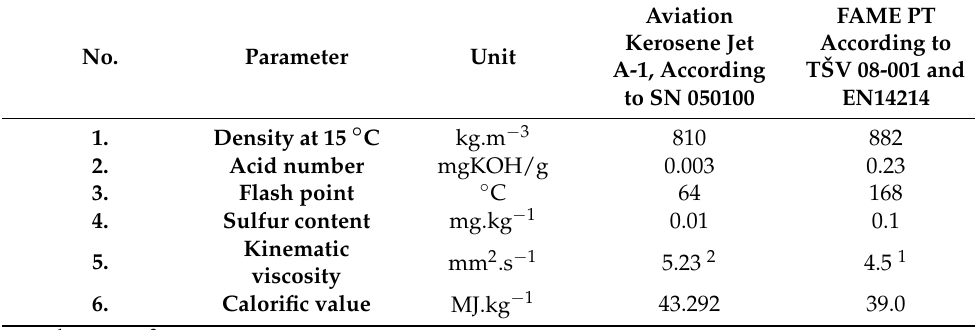
Table 4. Comparison of some parameters of Jet A-1 aviation kerosene and FAME biofuel.